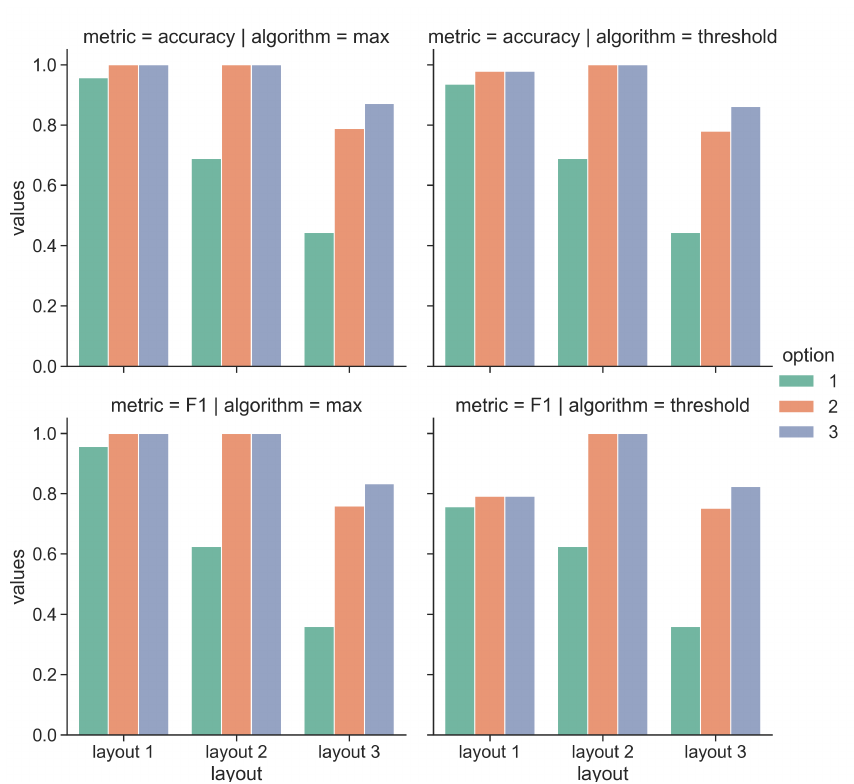
Figure 17. Performance results of the proximity algorithms with pilot 1.